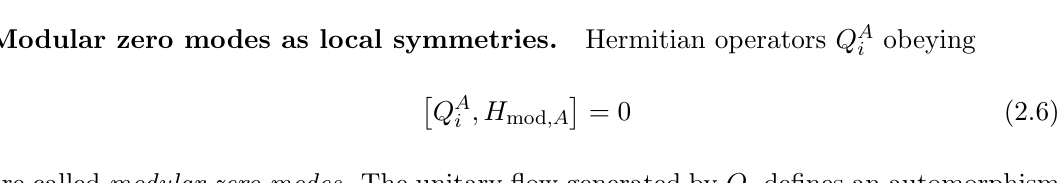
JHEP11(2019)094